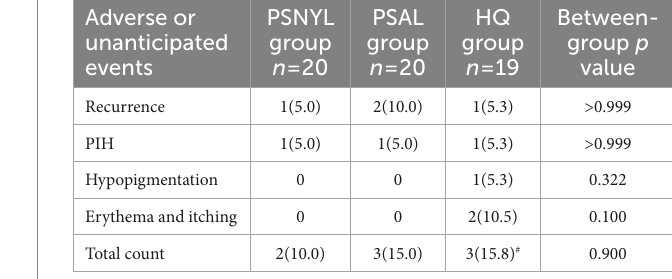
FIGURE 6 Patient assessment scores using a quartile grading scale. PSNYL, picosecond Nd:YAG laser (1,064 nm); PSAL, picosecond alexandrite laser (755 nm); HQ, hydroquinone (2%). Quartile Grading Scale: 0 (no